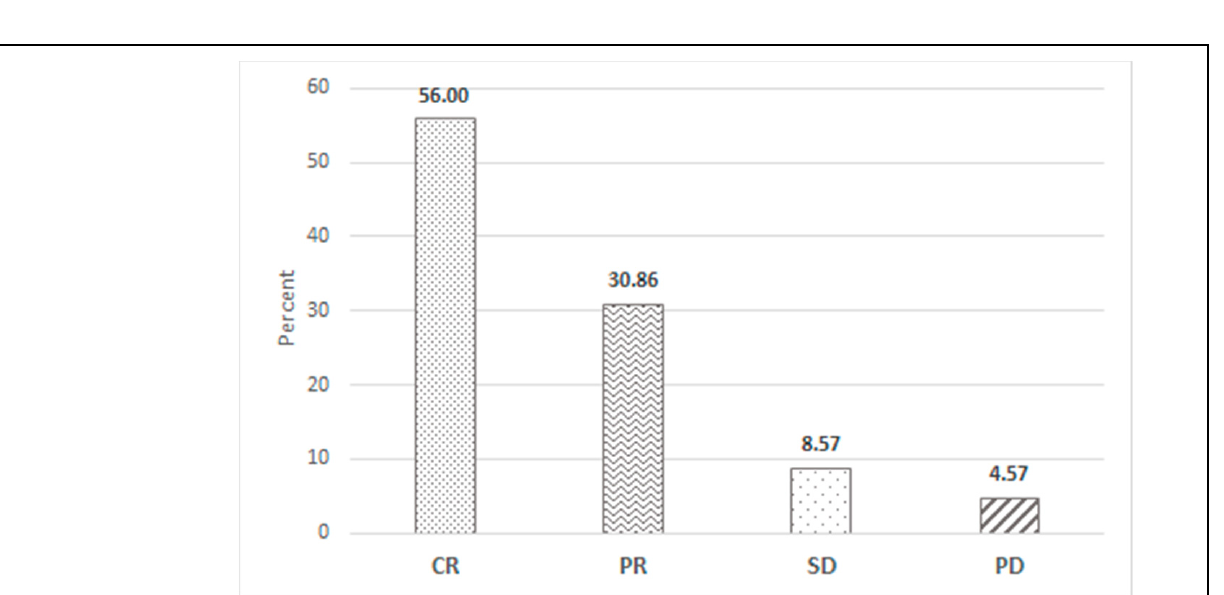
Figure 1. Response to bendamustine treatment. Best response obtained after receiving at least 1 bendamustine-containing course. 1 bendamustine-containing